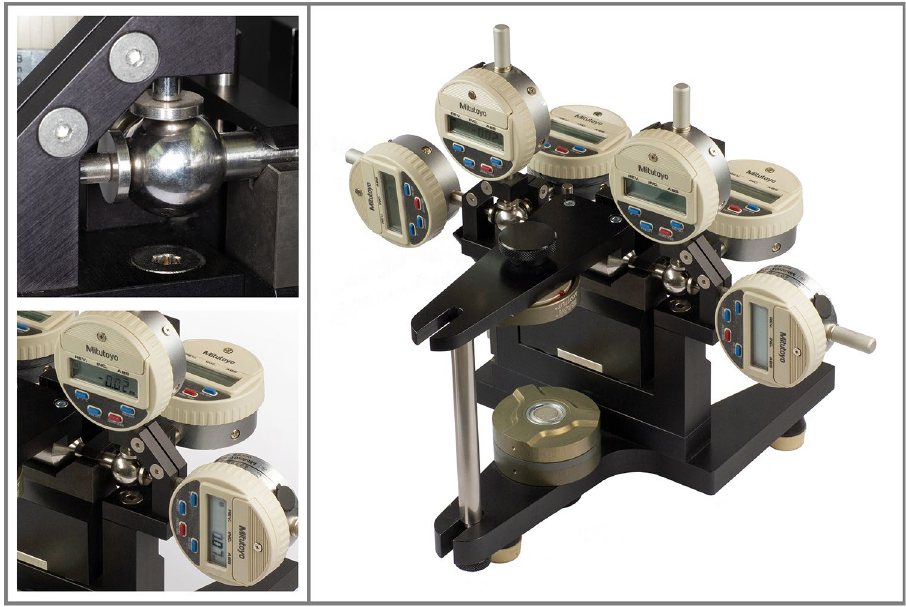
Figure 1. Condylar position indicator without dental casts. Overview and details of condylar sphere and 3D electronic measuring